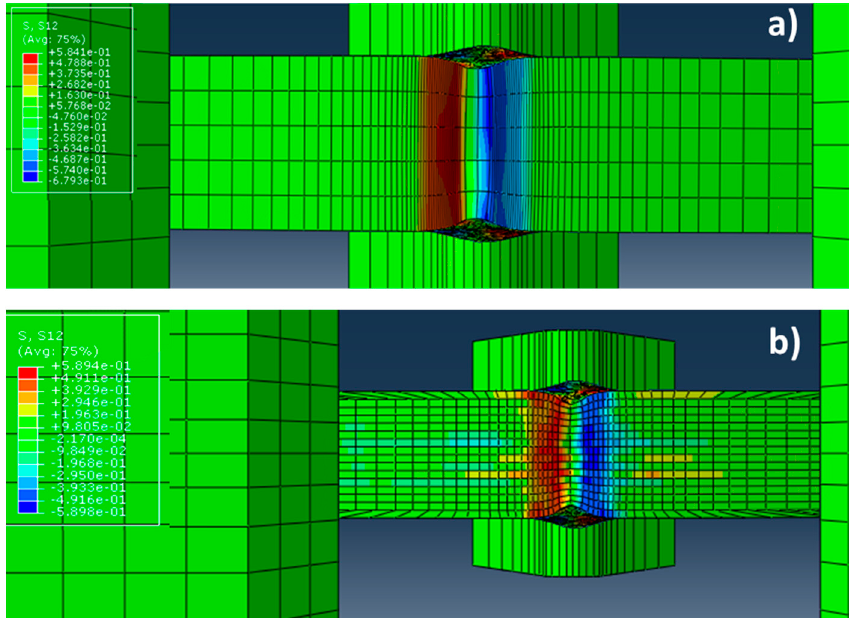
Figure 9. Distribution of τ 12 shear stresses in a plane corresponding to the view from below (XZ-plane), during the Charpy test for: ( a ) the single crystal case; and ( b ) the divider configuration.